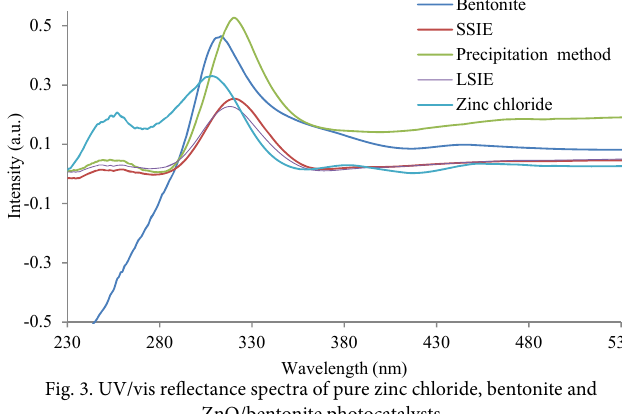
Fig. 3. UV/vis reflectance spectra of pure zinc chloride, bentonite and ZnO/bentonite photocatalysts